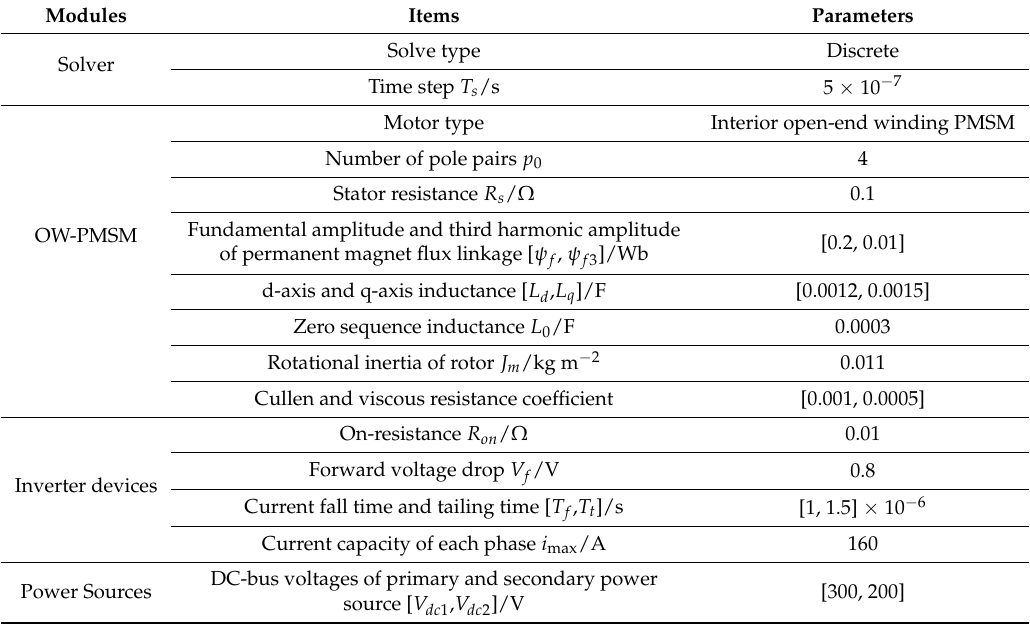
Table 2. Parameters of the drive system circuit. OW-PMSM: open-end winding permanent magnet synchronous motor.